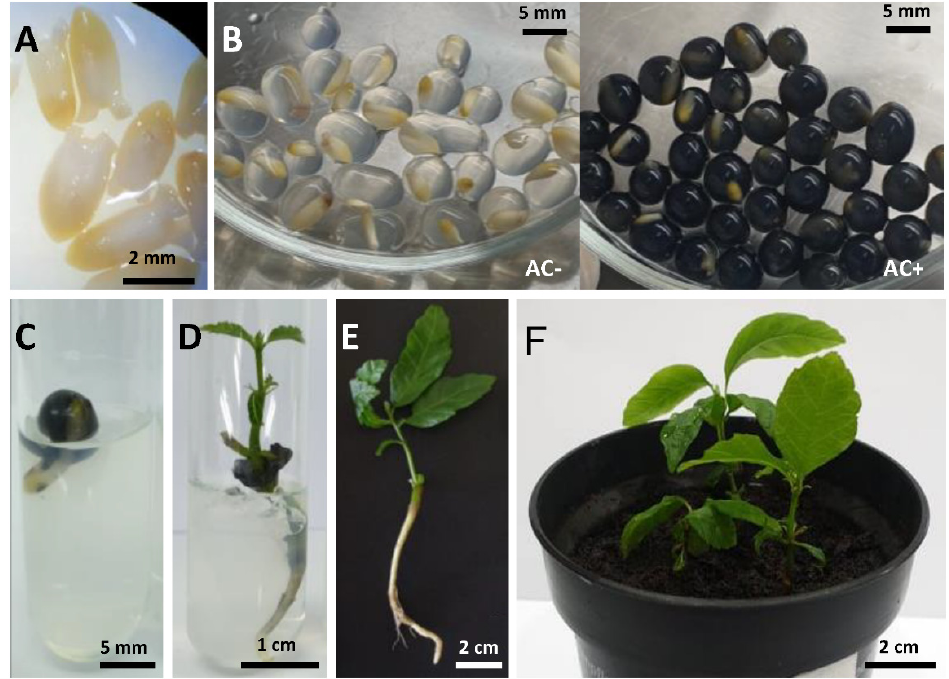
Figure 3. Plant regeneration from cryopreserved embryonic axes of Castanea sativa by encapsulation–vitrification. ( A ) Excised embryonic axes (EAs) used for cryopreservation. ( B ) Encapsulated EAs in 2.5% sodium alginate with (AC+) or without (AC − ) 0.3% ( w / v ) activated charcoal in the culture. ( D ) Primary plantlet development 2 weeks after survival assessment cryopreserved by